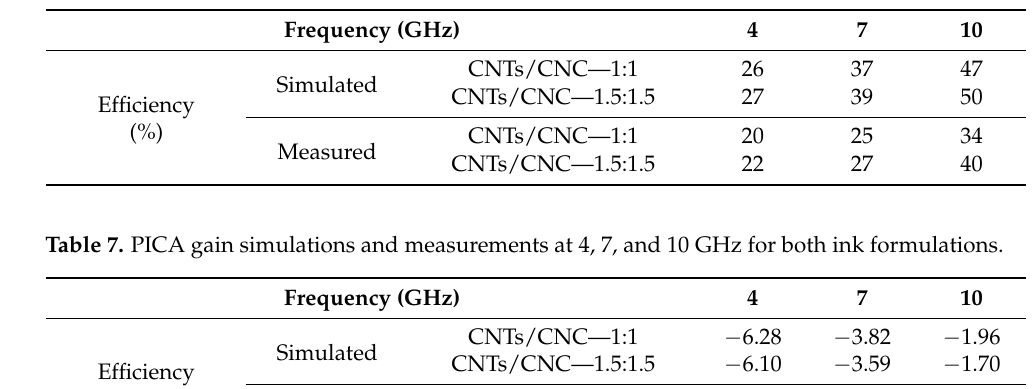
Table 6. PICA efficiency simulations and measurements at 4, 7, and 10 GHz for both ink formulations.